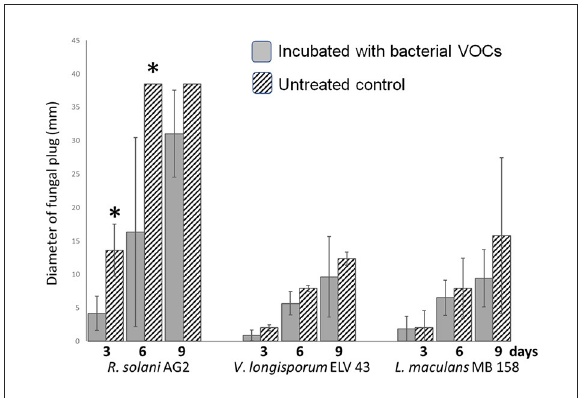
FIGURE1 VOCs assay of three fungal plant pathogens ( R. solani AG2, L. maculans MB 158 and V. longisporum ELV 43) and S. plymuthica HRO-C48 on solid PDA for 3, 6, and 9 days. Dashed columns show growth of fungi in the presence of S. plymuthica HRO-C48 VOCs, while gray columns illustrate the growth of the selected fungi without bacterial VOCs (untreated control). The assay was performed in three replicates. The bars represent standard errors, while an asterisk * denotes values that varied significantly from control group values ( P < 0.05) defined using pairwise t -test or non-parametric Mann–Whitney U -test, depending on the distribution of the